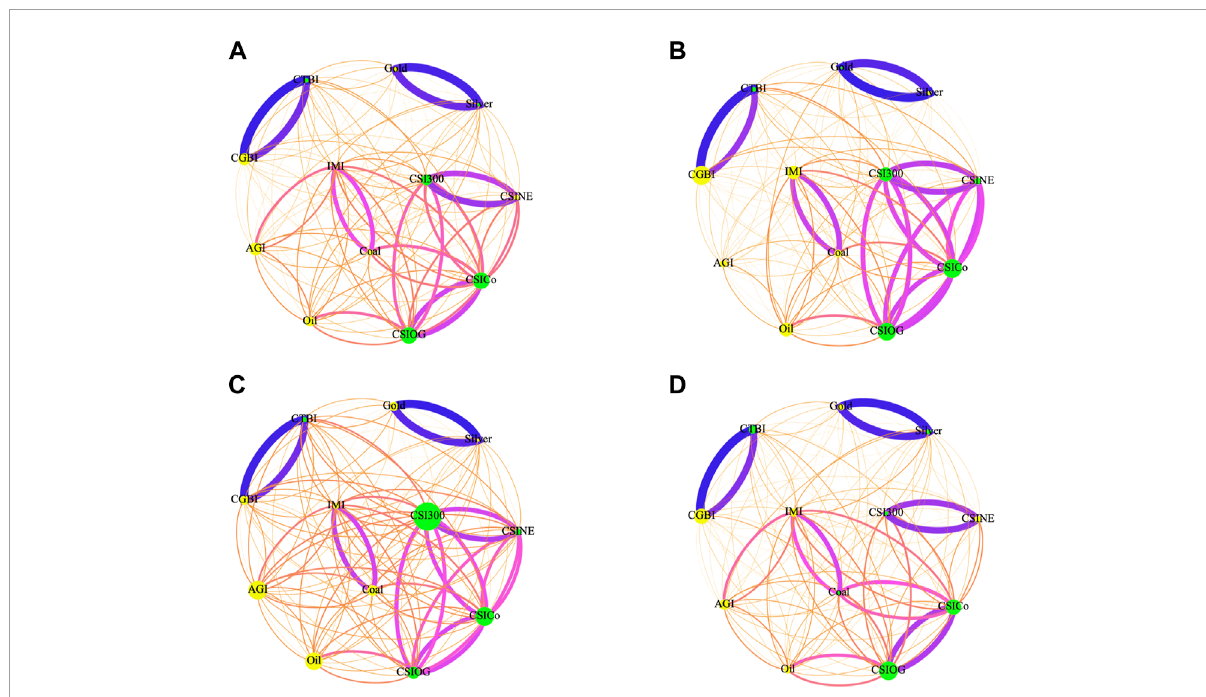
FIGURE 5 Network connectedness: (A) The whole sample period; (B) Pre-pandemic period; (C) The COVID-19 pandemic; (D) Post-pandemic period.